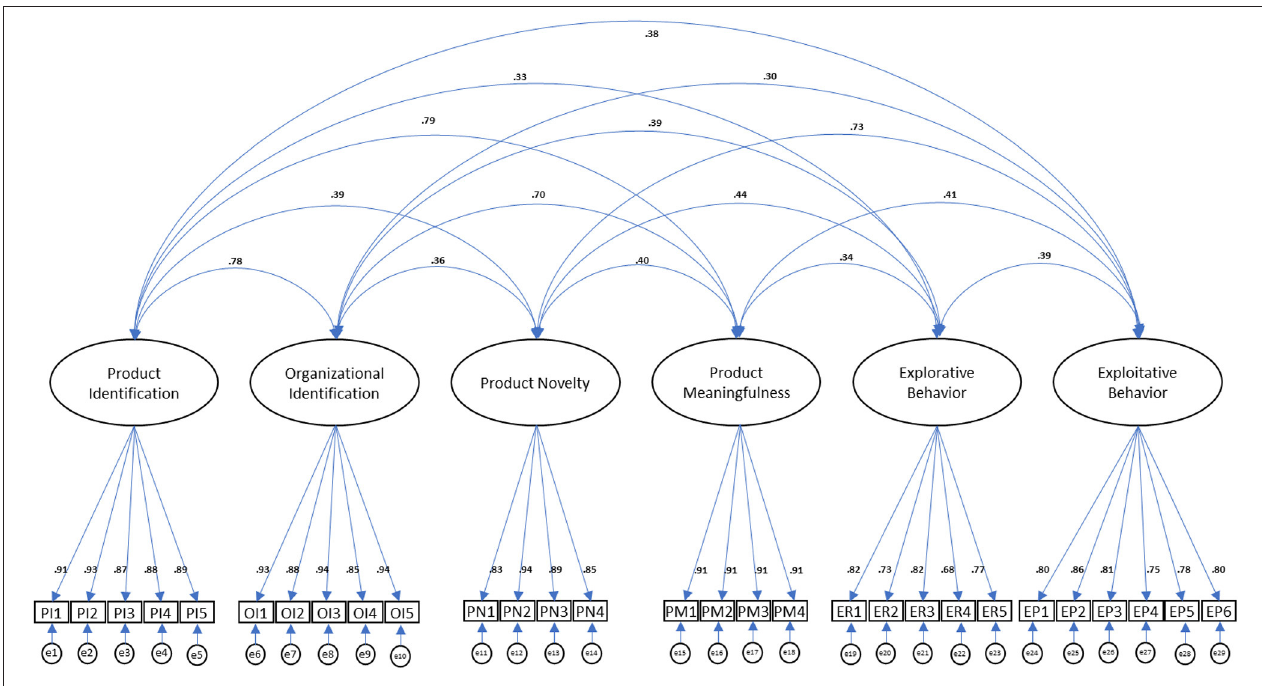
FIGURE 2 | Structural equation models for reliability and validity